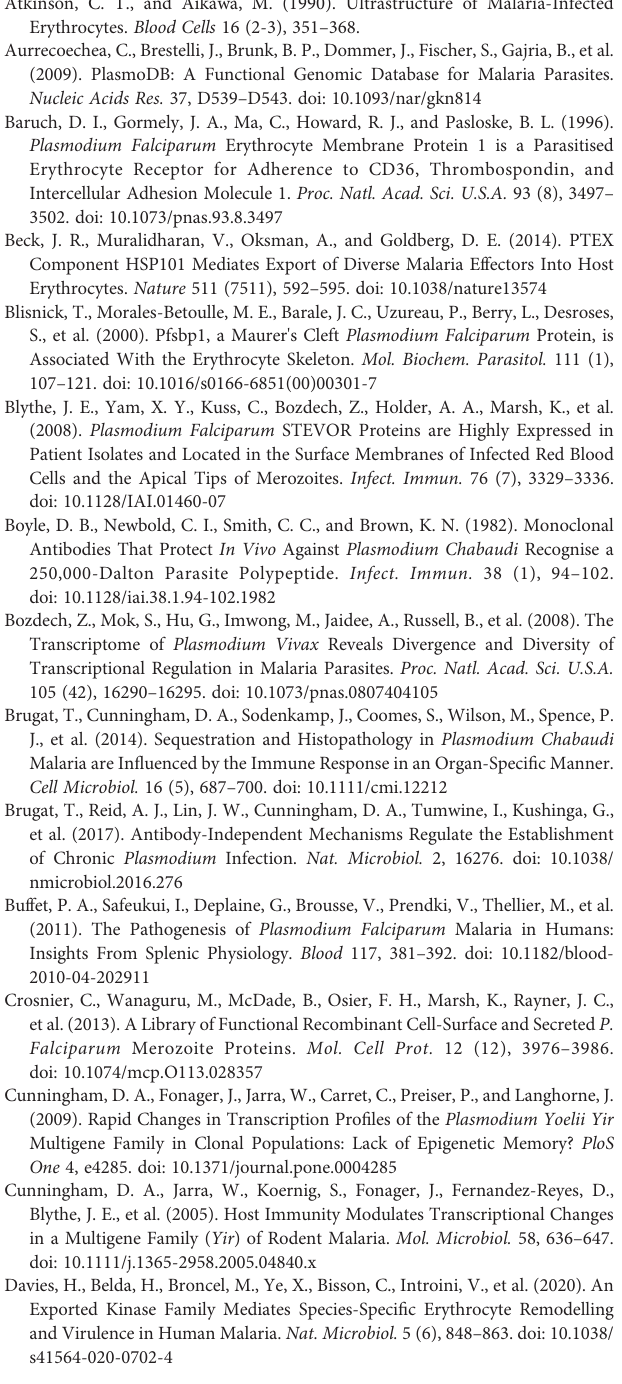
Supplementary Table 2 | P. chabaudi PIR proteins identi fi ed as reciprocal best hits of each motif designed against the S7 and L1